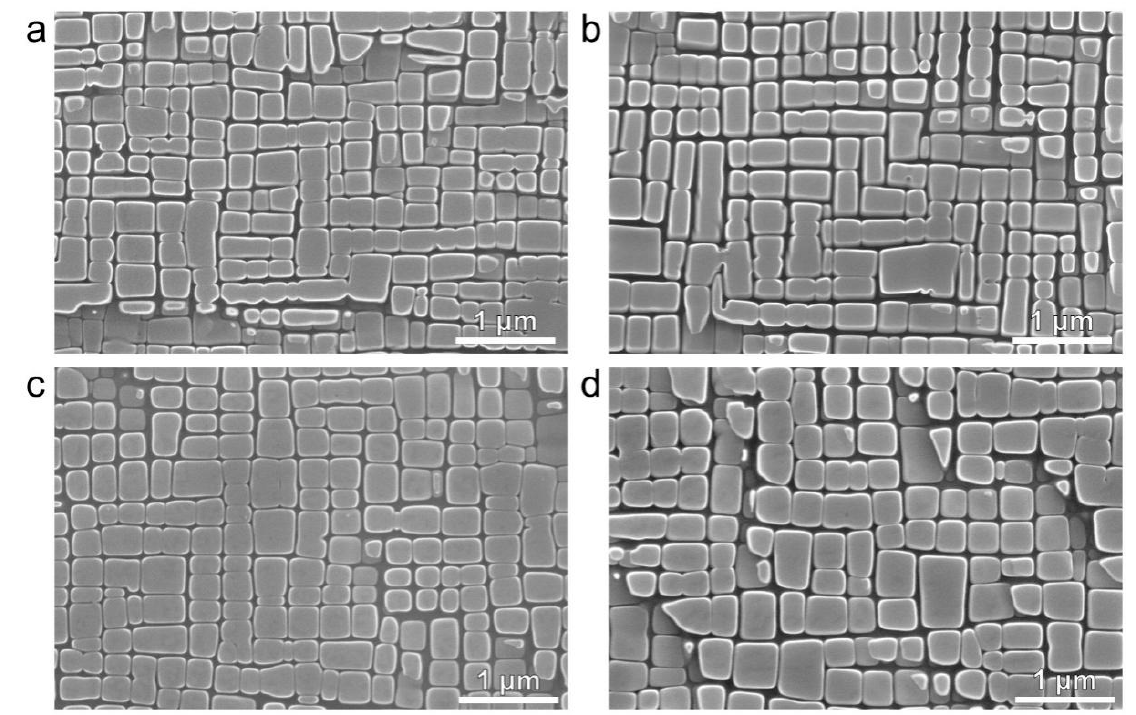
Figure 3. SEM images of Ni-based SX superalloys after solution and aging treatments: ( a ) 3Ta6.4Al1Ti; ( b ) 0Ta6.4Al2Ti; ( c ) 3Ta6Al1Ti; ( d ) 0Ta6Al2Ti. Four SX superalloys all have typical γ / γ′ two-phase microstructure.